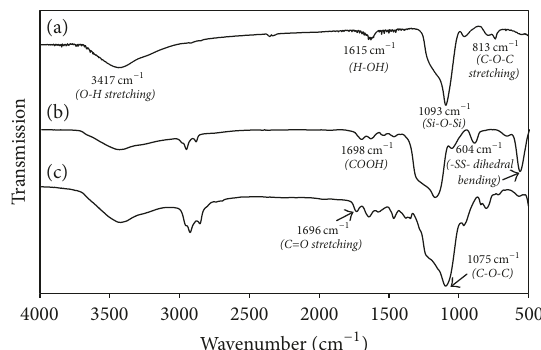
Figure 3: FTIR spectra: PNS (a) [7]; PNS-SS-ADA (b) [7]; PNS-SS- ADA@CD-mPEG